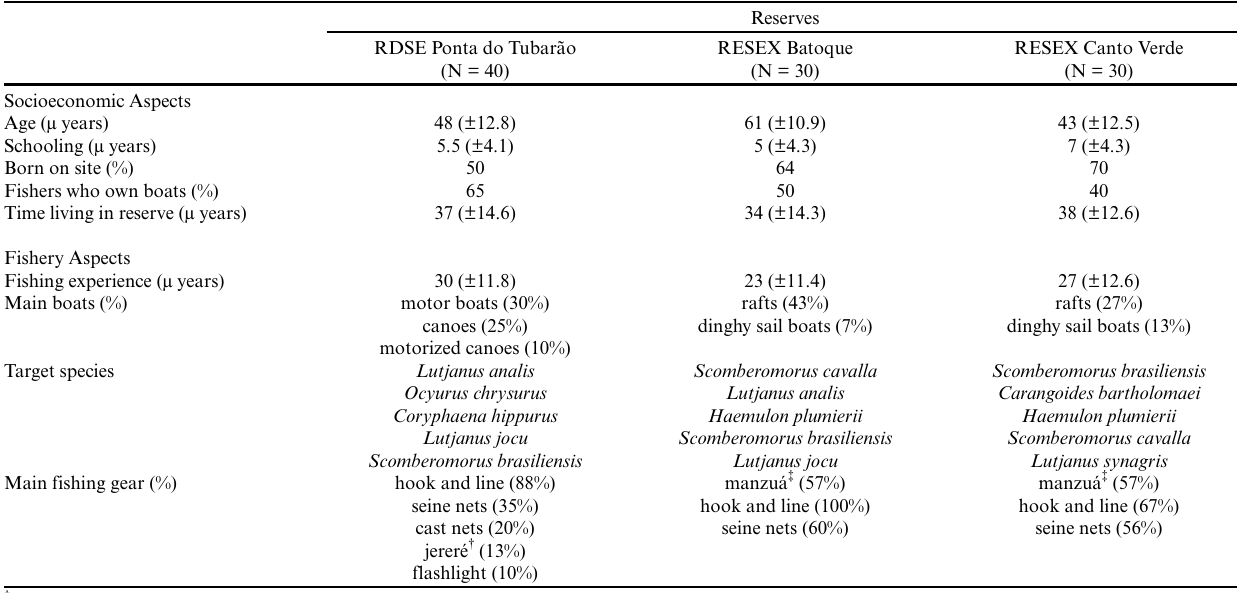
Table 2 . Socioeconomic and fishery aspects of fishing communities in three marine protected areas located on the northeastern Brazilian coast: RDSE Ponta do Tubarão, RESEX Batoque, and RESEX Canto Verde. N = number of fishers; µ = Mean; ± = Standard